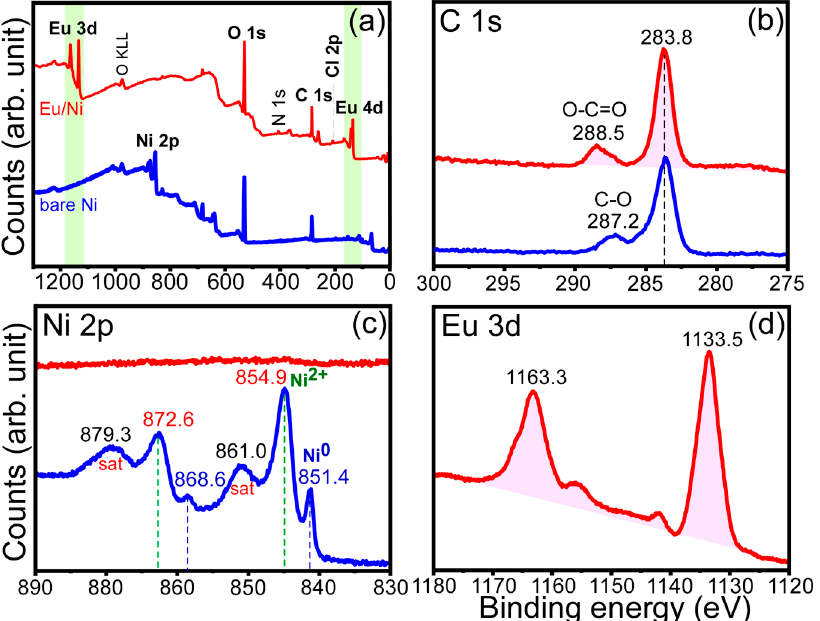
Figure 6. Survey ( a ), high-resolution C 1s ( b ), Ni 2p ( c ), and Eu 3d ( d ) XPS spectra before and after Eu electrodeposition over a bare Ni sheet.